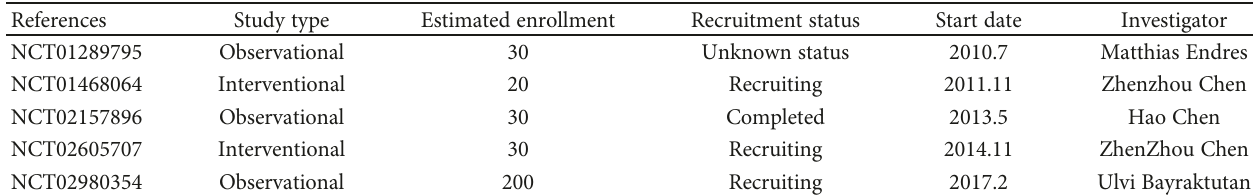
Figure 1: EPCs interact with the neurovascular unit. In the early stage (within 24 to 48 hours), EPCs provide nutritional support for glial cells and reduce neuronal apoptosis through secreting cytokines; during the acute phase (within 1 week), EPCs repair the blood-brain barrier (BBB) and reduce cerebral edema by replacing and repairing the vascular endothelium or promoting the proliferation and migration of resident ECs, thereby reducing nerve cell injury in the ischemic penumbra; in the late acute phase (after 1 week), EPCs recover and reconstruct the neurological functions of nerve cells in the necrotic region by promoting angiogenesis, blood supply, and proliferation and migration of neuroblasts. The fi gure partly refer to Li et al. Table 1: Clinical trials for ischemic stroke with endothelial progenitor cells.